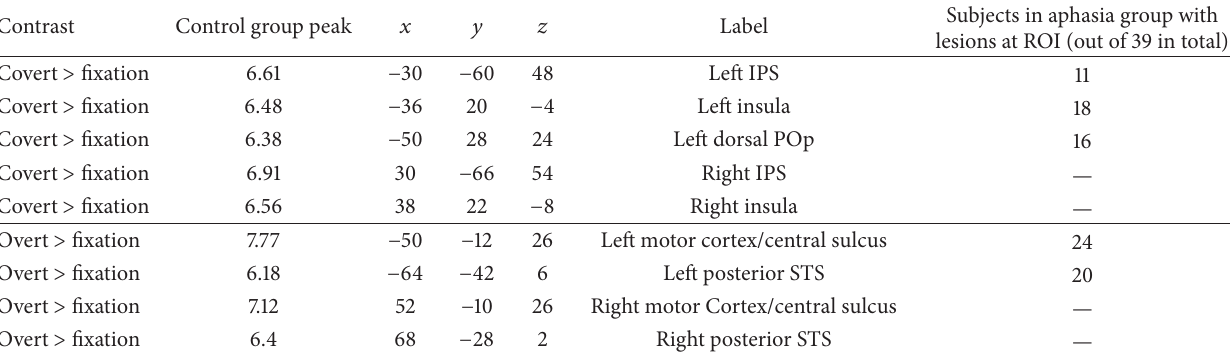
Table 5: Regions of interest drawn from the contrasts in the control group.